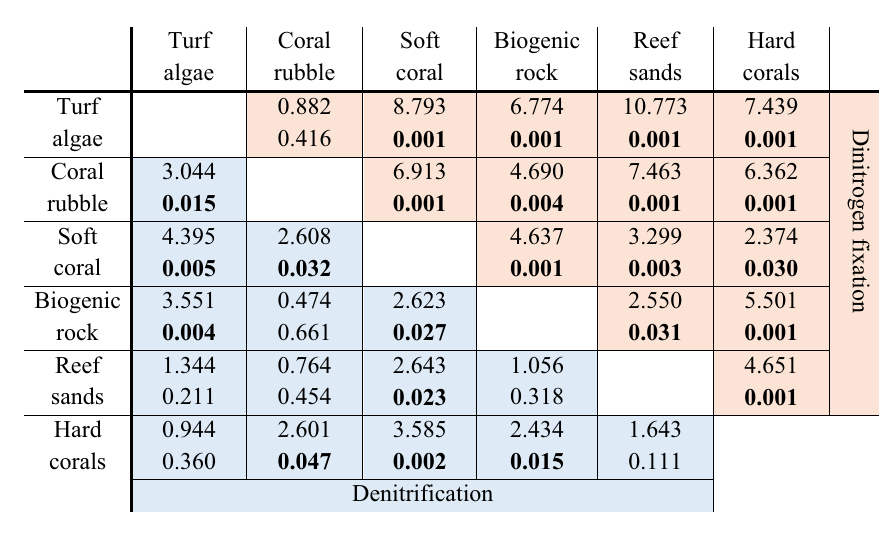
Table 1. Results of permutational analysis of variance (PERMANOVA) and subsequent pair-wise tests for N 2 fixation (highlighted in salmon) and denitrification (highlighted in blue) in all benthic categories. Significant p -values in bold. Top: t-values; bottom: p